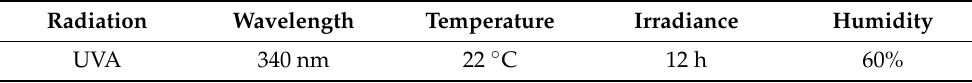
Table 2. Setting Parameters for the artificial photo-ageing process of MPs in the climate room. Radiation Wavelength Temperature Irradiance Humidity UVA 340 nm 22 ◦ C 12 h